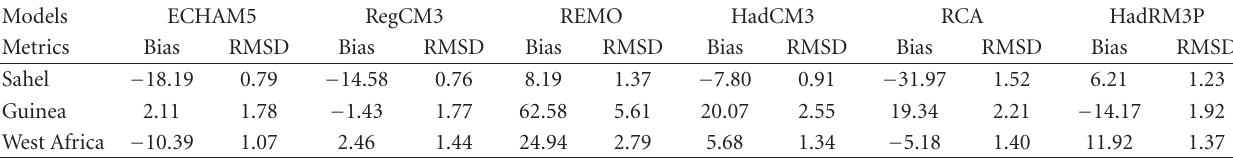
Table 4: Mean bias and spatial root mean square di ff erence (RMSD) at di ff erent subdomains considered in Figure 1(b) from individual GCMs (ECHAM5 and HadCM3) and Individual RCMs (RegCM3, REMO, HadRM3P, and RCA) rainfall with respect to GPCP. Models output are interpolated to GPCP grid. Bias is expressed as percentage of GPCP value while RMSD as mm/day.